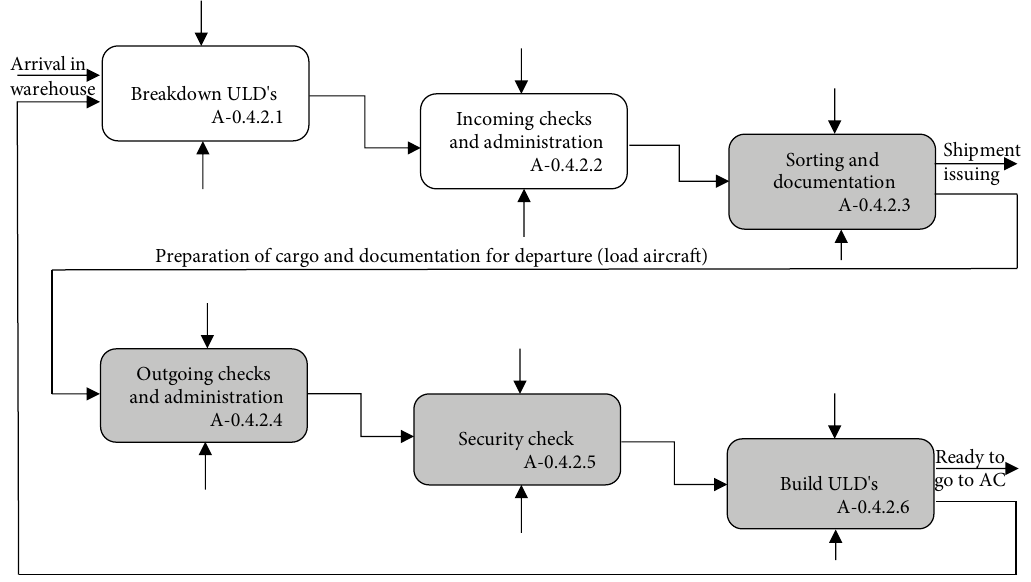
Figure 4: Further decomposition—cargo handling subprocess—(arrivals-departures)—landside.